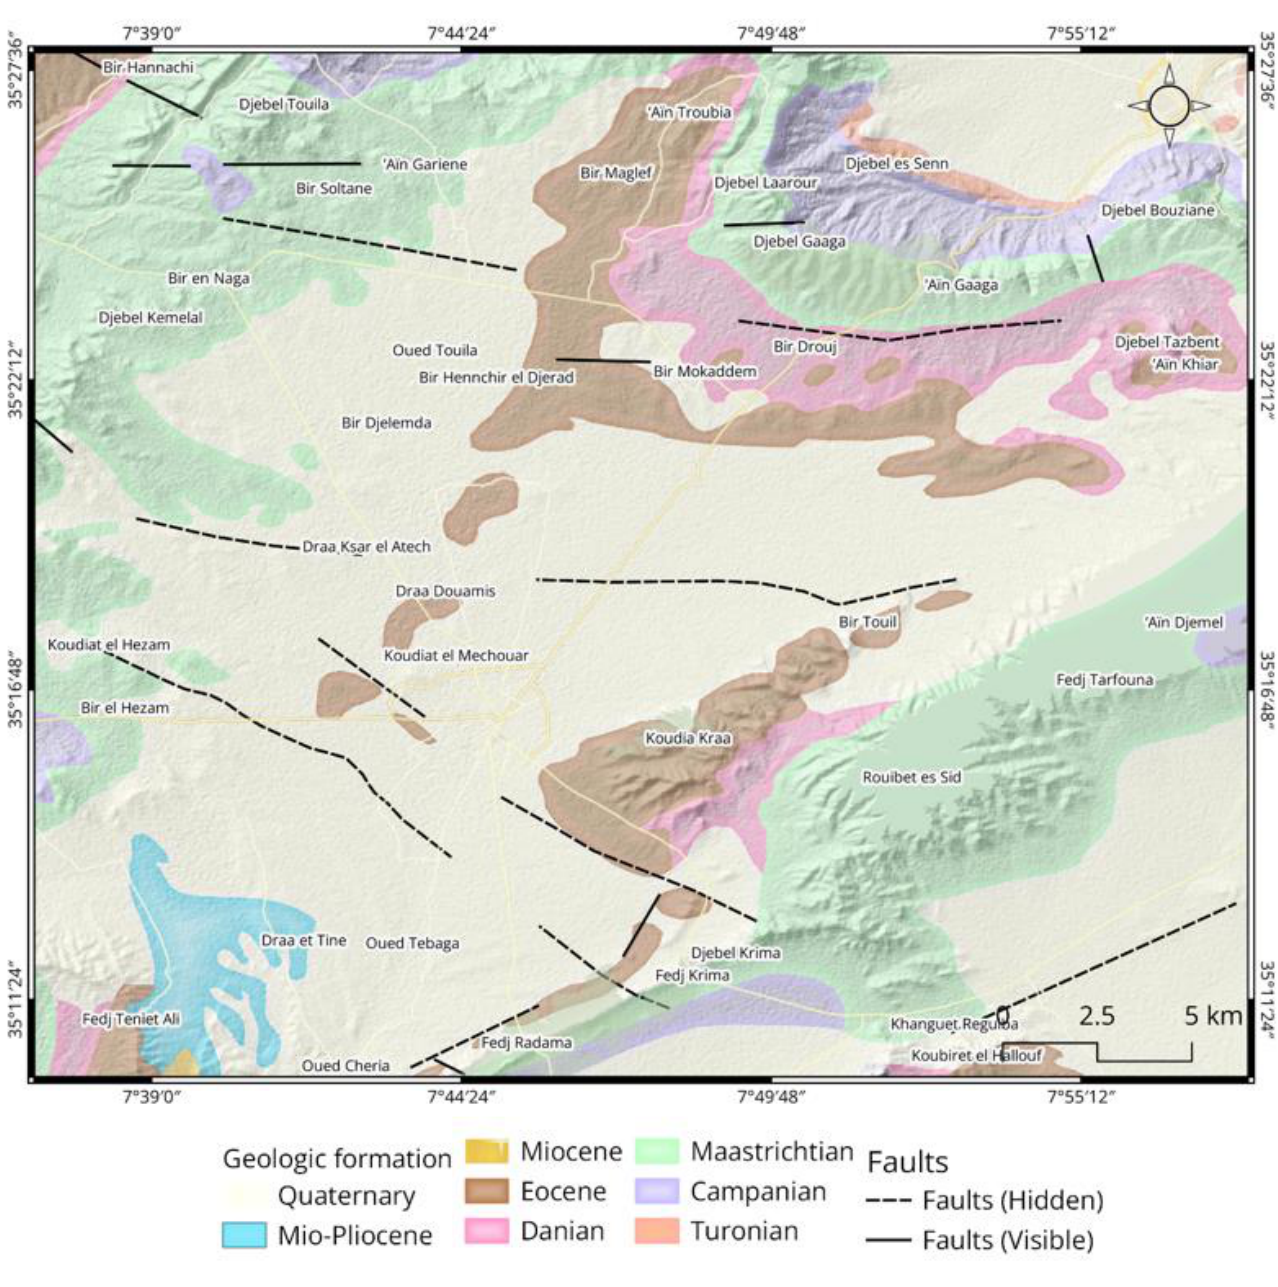
Figure 2. Regional geological map of the study area showing the dominant Quaternary formation and the Maastrichtian and Eocene formations.